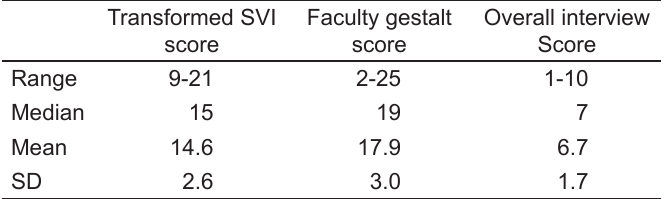
Table. Range, median and mean transformed Standardized Video Interview (SVI), faculty gestalt, and interview scores, with standard deviations